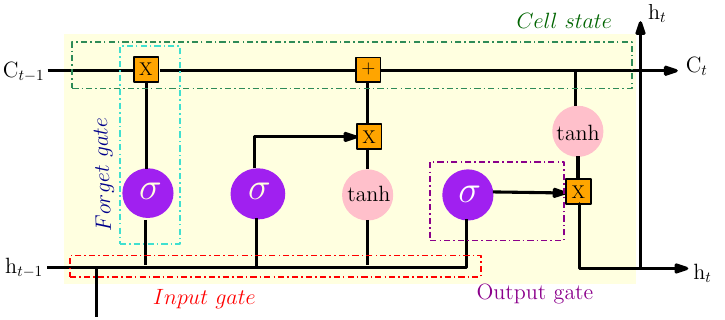
Figure 22. The internal structure of the LSTM